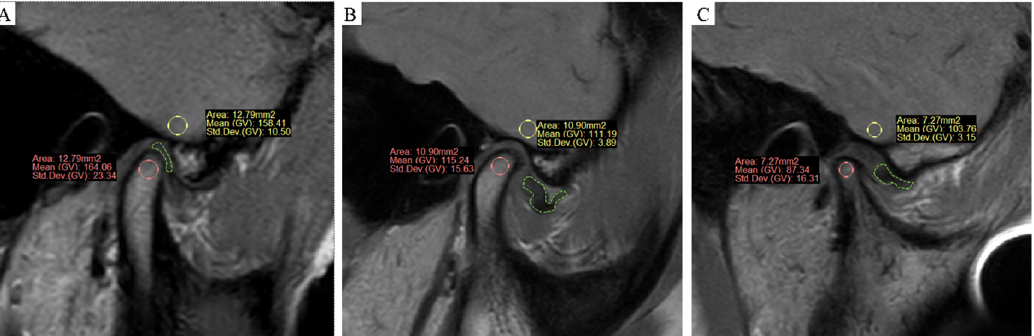
Figure 1. ( A – C ) MRI sampling and measurement, oblique sagittal at closed mouth PDWI. ( A ) Normal group (group 1): the articular disc marked in green was in a normal position, and the status of the condyle was healthy. ( B ) ADD without the CR group (group 2): ADD occurred, but the status of the condyle was still healthy. ( C ) ADD with CR group (group 3): not only ADD occurred, but the shape and volume of the condyle was significantly resorbed.